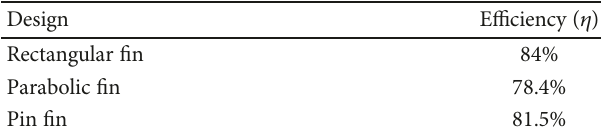
Table 1: Fin e ffi ciency based on design type.